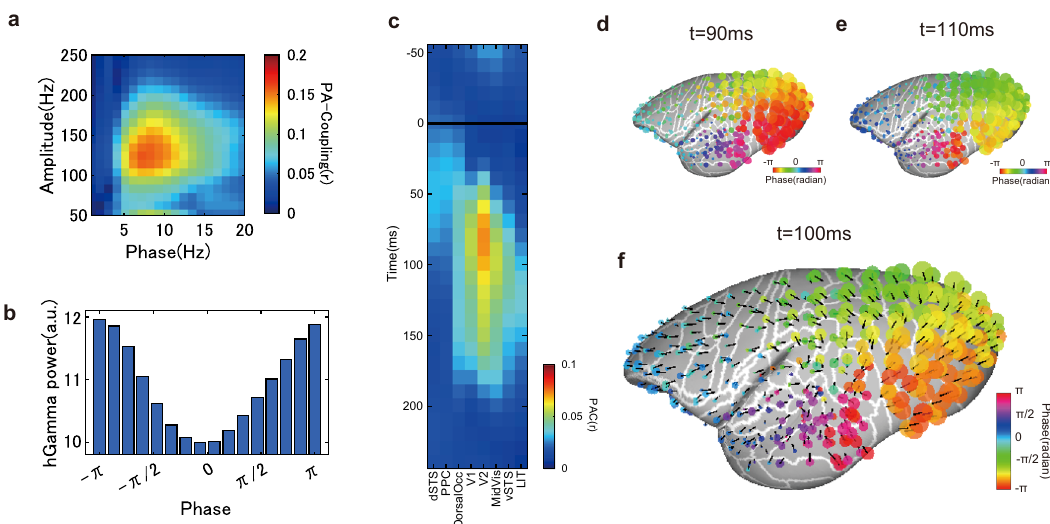
Fig. 7 High-gamma signal coupled with a traveling wave of theta oscillations. a Phase-amplitude coupling (PAC) of the perisaccadic period from an example electrode. High-gamma signal amplitude correlated best with the phase of theta and alpha oscillations (6 – 12 Hz). b High-gamma signal relative to the phase of theta oscillations (8 Hz) in the same electrodes as in ( a ). The High-gamma signal is highest at ± π rad and lowest at 0 rad. c Perisaccadic theta phase – high-gamma amplitude coupling across areas. Each column represents the average PAC from multiple electrodes belonging to the same cortical region. The solid black line is saccade onset. d , e Phase of theta oscillations at 90 and 110 ms from saccade onset. The phase of theta oscillations showed a gradient across adjacent electrodes. The phase of two adjusted time points shows the direction in which the phase moved along the cortical surface. f Directionality of traveling wave propagation. The black thick lines represent the direction of the traveling wave (the direction in which the same phase appeared at the next time point). The pattern of wave propagation was comparable to that of a high-gamma signal trajectory.